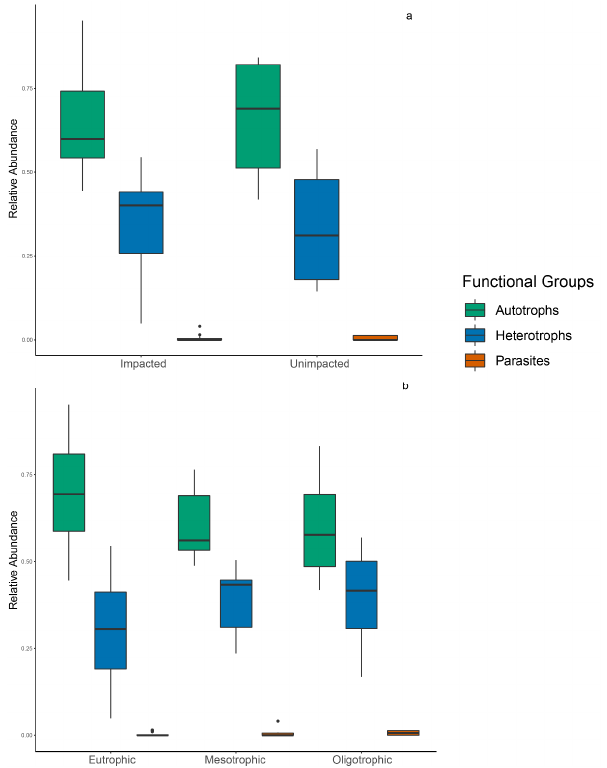
Figure 8. Relative abundance box plot of functional groups in protists communities within impact status ( a ) and trophic state ( b ), during 5–10 October 2019, along the New River, Belize. Colors indi- cate functional groups—green = Autotrophs; blue = Heterotrophs; red = Parasites.